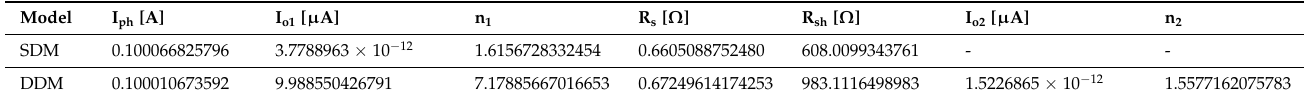
Table 8. The parameters of PVM 752 GaAs thin-film photovoltaic panel.